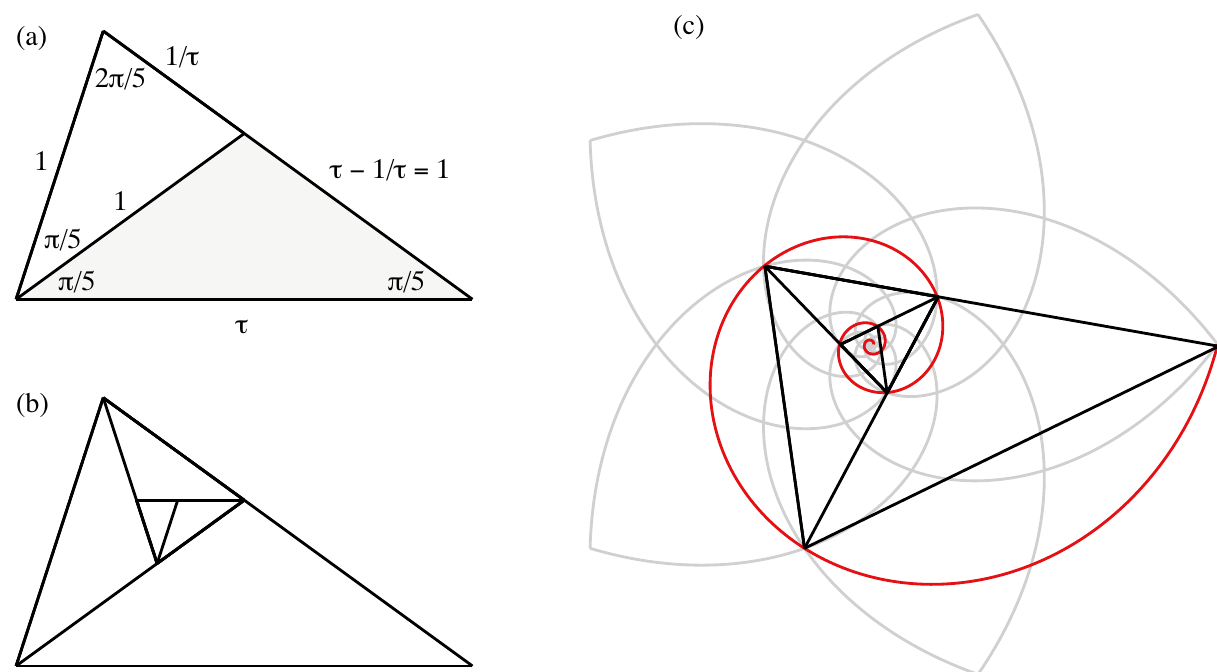
Figure 5. (a) With τ given by Eq. (42), an isosceles triangle with side lengths ratios τ : τ : 1, can be subdivided into two isosceles triangles, one of which (white interior) has side length ratios τ : τ : 1 but side lengths a factor τ smaller than those in the original triangle. (b) We can continue the process of subdivision to generate a nested set of isosceles triangles with side length ratios τ : τ : 1, but at each step of the pro- cess, the side length of the triangle just produced is reduced from that of its parent by a factor of τ . (c) The intersections of the logarithmic spirals (43) generate a distribution of points with five-fold rotational symmetry about the origin. The logarithmic spiral ln r / ln τ = θ /(3 π /5), shown in red, passes through these points of intersection, with the distance from the origin increasing by a factor of τ between any two consecutive intersections. With suitable scaling and rotation, the inscribed triangles shown in diagram (b) can be placed with their vertices located at the intersection points (figure adapted from Ninham and Lidin